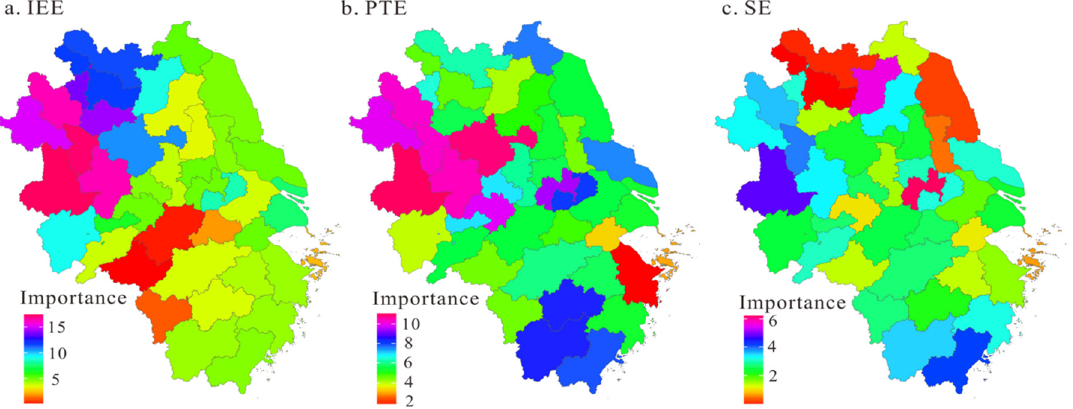
Figure 4. Spatial distribution of the importance of ( a ) IEE, ( b ) PTE and ( c ) SE.